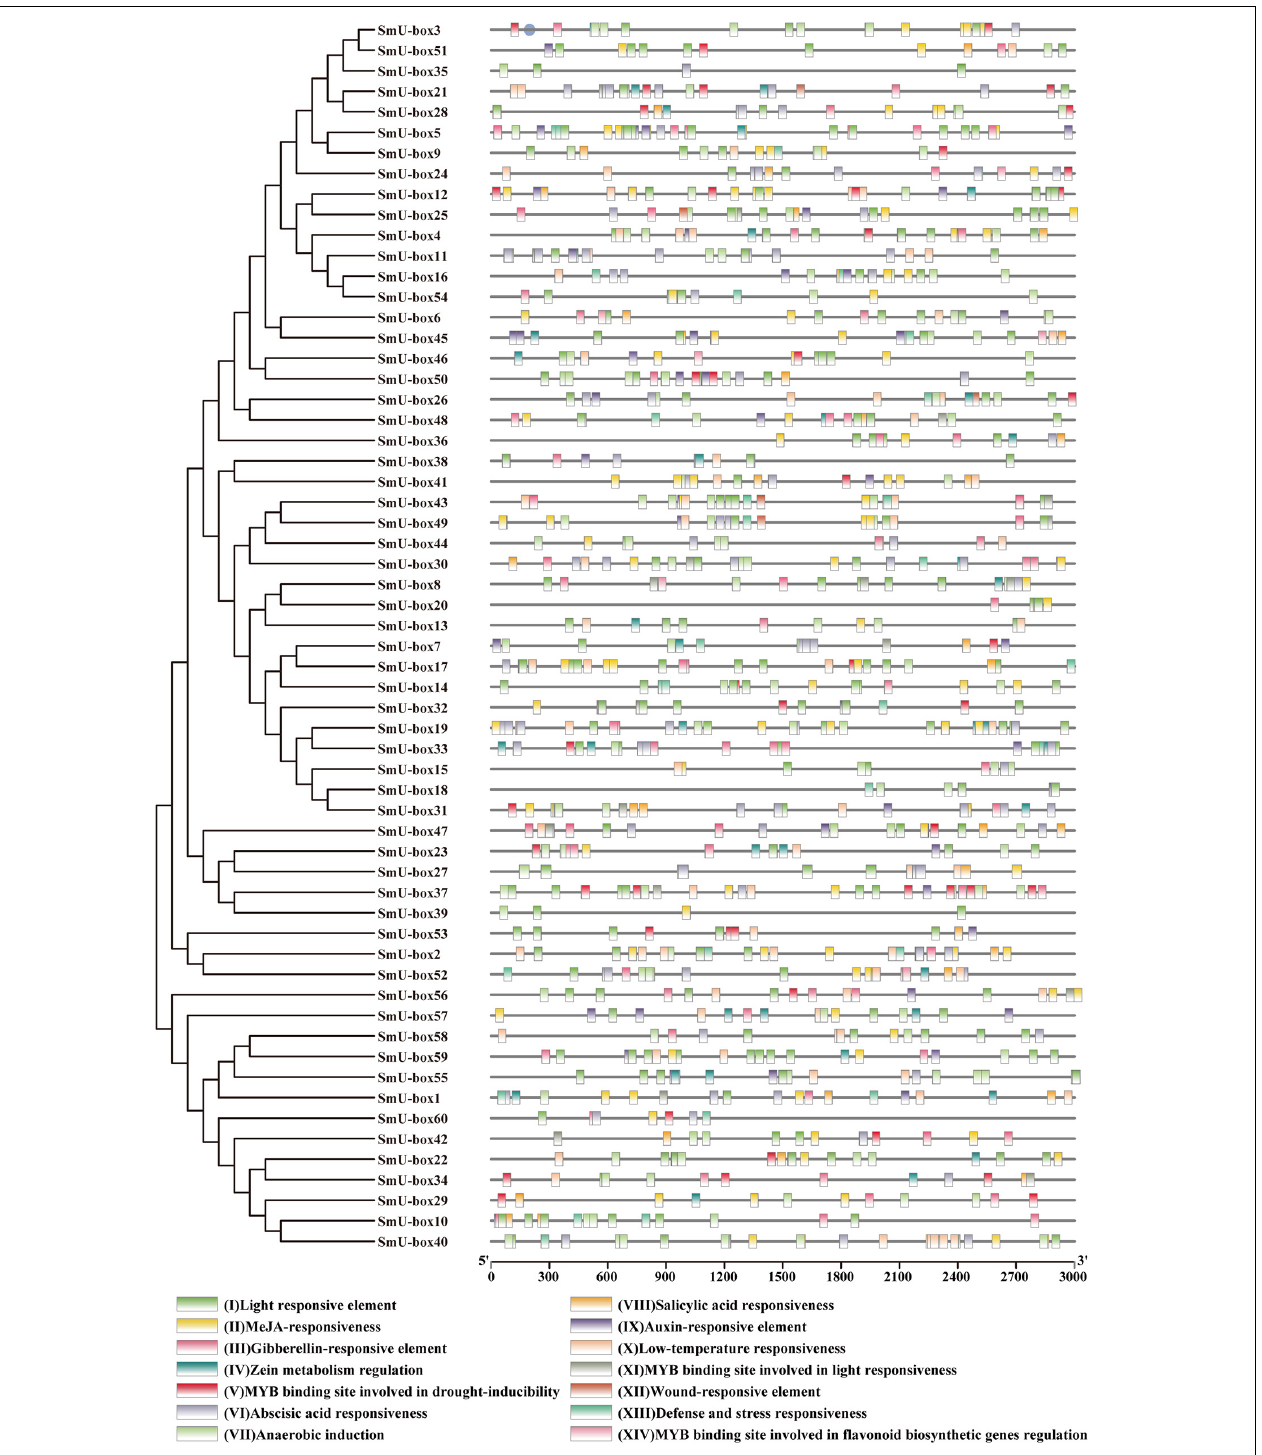
FIGURE 3 | The cis -acting elements draft of the putative promoters of 60 U-box genes in S. miltiorrhiza . The distribution pattern of 14 cis -acting elements of the putative promoters of U-box genes in S. miltiorrhiza . The phylogenetic tree is the same as in Figure 1 . Fourteen cis -acting elements including (I) Light responsive element; (II) MeJA-responsiveness; (III) Gibberellin-responsive element; (IV) Zein metabolism regulation; (V) MYB binding site involved in drought-inducibility; (VI) Abscisic acid responsiveness; (VII) Anaerobic induction; (VIII) Salicylic acid responsiveness; (IX) Auxin-responsive element; (X) Low-temperature responsiveness; (XI) MYB binding site involved in light responsiveness; (XII)Wound-responsive element; (XIII) Defense and stress responsiveness; (XIV) MYB binding site involved in flavonoid biosynthetic genes regulation.